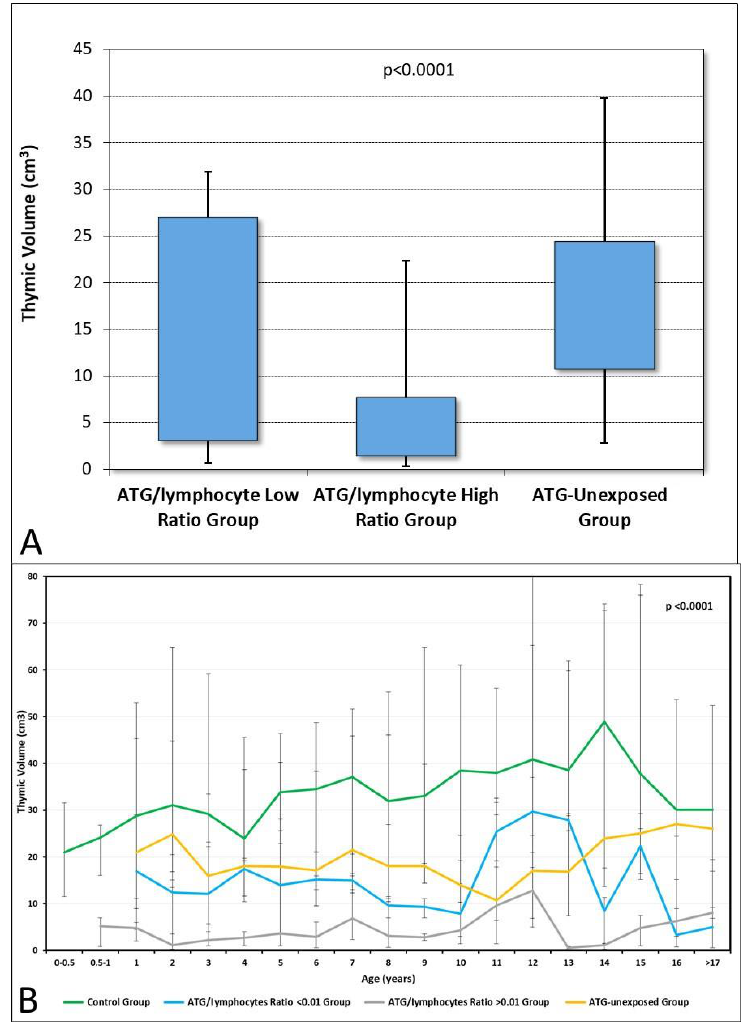
Figure 4. Thymic volume (cm 3 ) at one year after HSCT. ( A ) Box and whisker plot of thymic volume in the low ATG/lymphocyte ratio group (first box), high ATG/lymphocyte ratio group (second box), and ATG-unexposed group (third box). ( B ) Line graph presentation of the age-matched thymic volume in the low ATG/lymphocyte ratio group (blue line), high ATG/lymphocyte ratio group (grey line), ATG-unexposed group (yellow line), and ontrol group (green line). We analyzed a correlation between the thymic volume and the RTE count in the two ATG-exposed subgroups and the ATG-unexposed group one year after HSCT (Fig- ure 5). A strong correlation ( p < 0.0001) was found between the thymic volume and the number of RTEs in the two ATG-exposed subgroups (Figure 5A,B), while no such corre- lation ( p = 0.1411) was found in the ATG-unexposed group (Figure 5C).